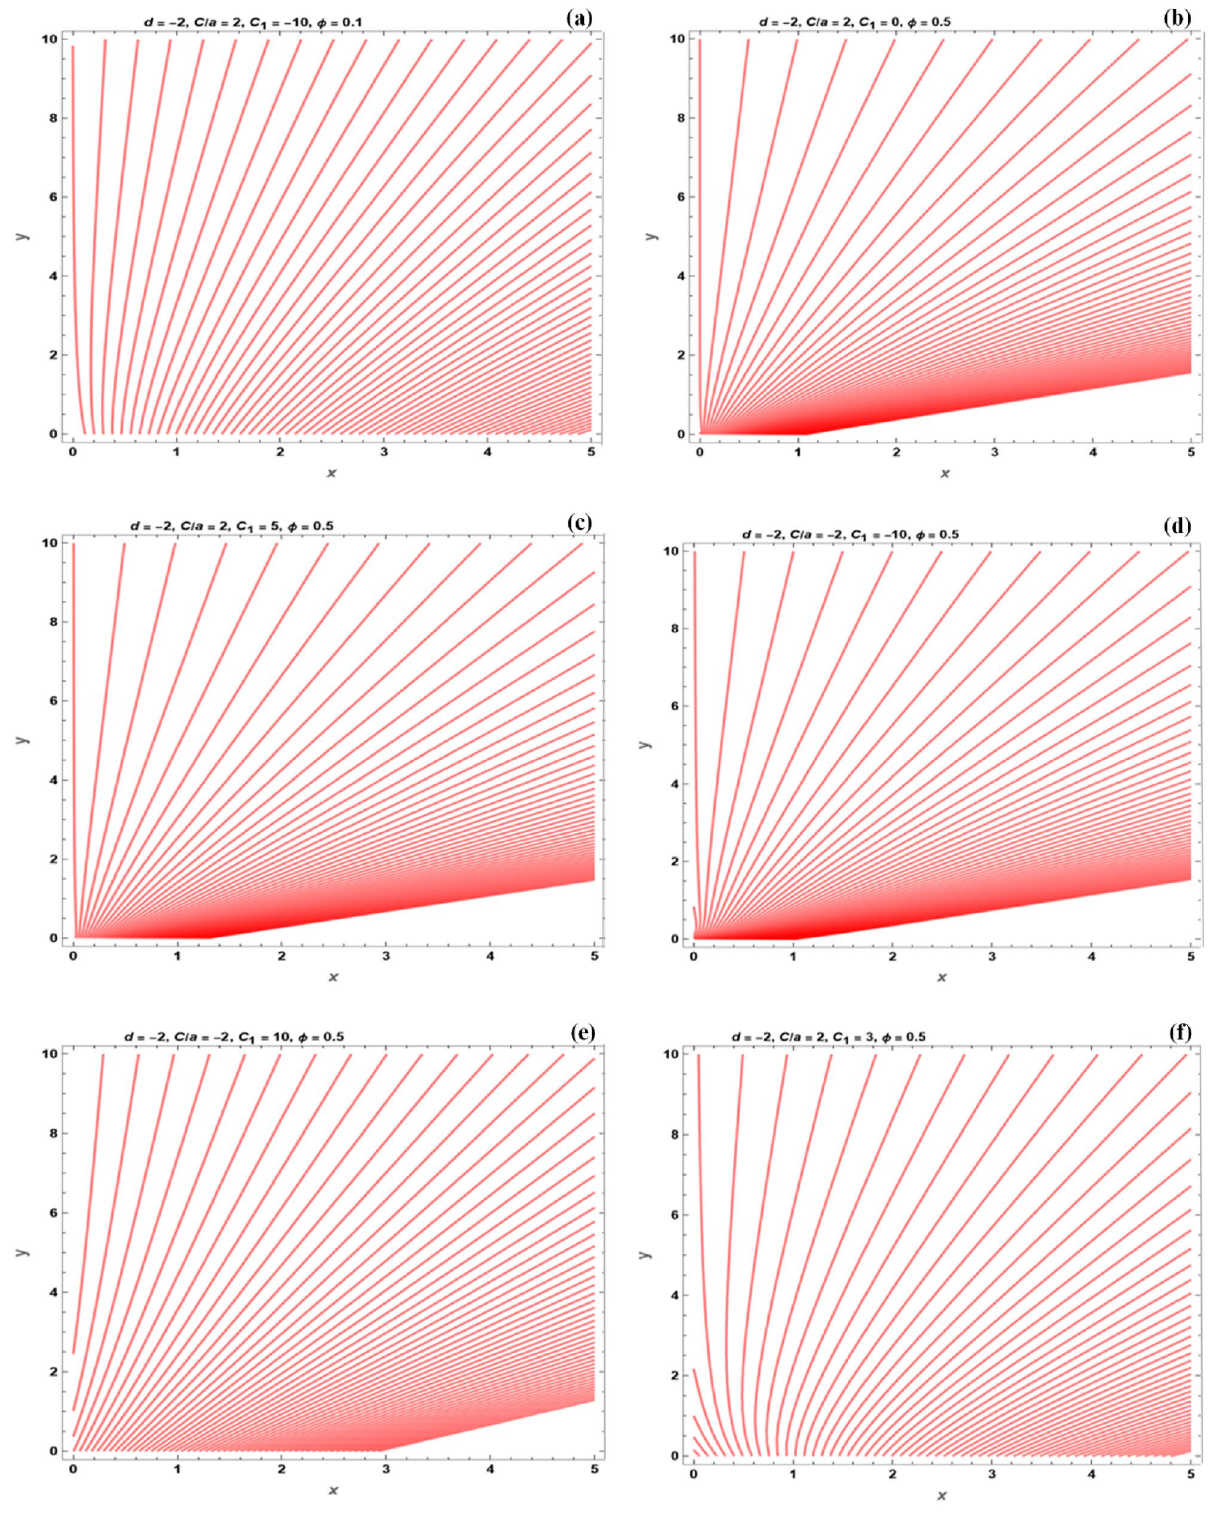
Figure 14. The flow field under the effect of various parameters, for the shrinking